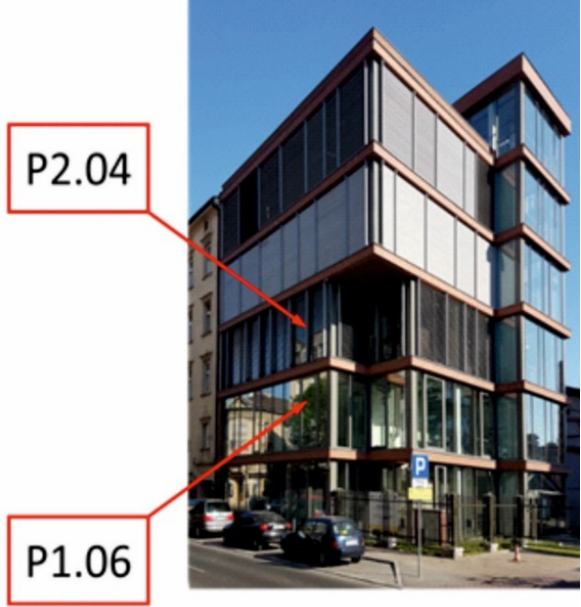
Figure 1. Location of test room P2.04 (with external venetian blinds) and P1.06 (with no venetian blinds).